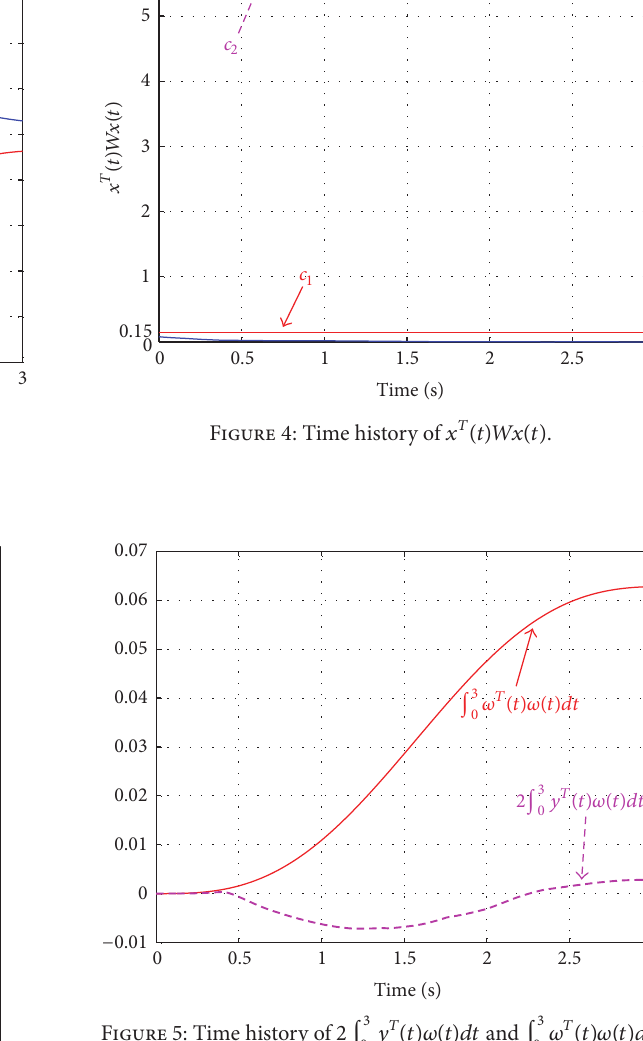
Figure 5: Time history of 2 ∫